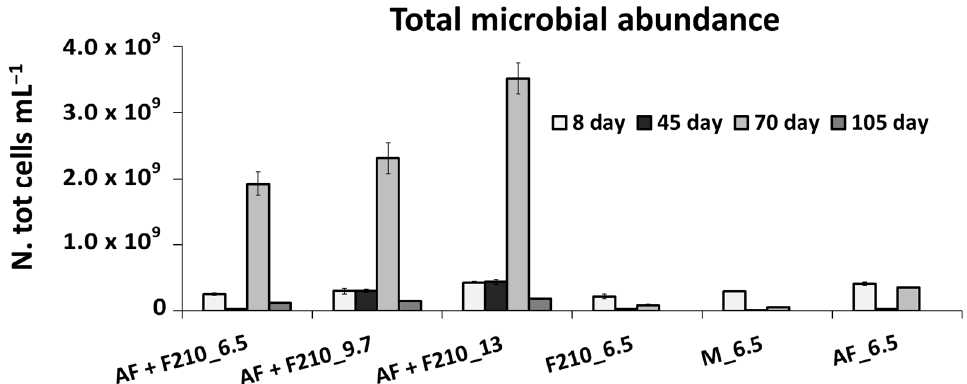
Figure 3. Total microbial abundance (N. tot cells mL − 1 ) determined by direct count after DAPI staining for all the experimental tests at days 8, 45, and 70 (white, black, and light grey bars, respectively). In addition, for all combined bioaugmented tests, i.e., AF + F210_6.5, AF + F210_9.7, and AF + F210_13, the total microbial abundance at day 105 was also determined (dark grey bar). During the experiment, shifts in microbial community composition were observed.